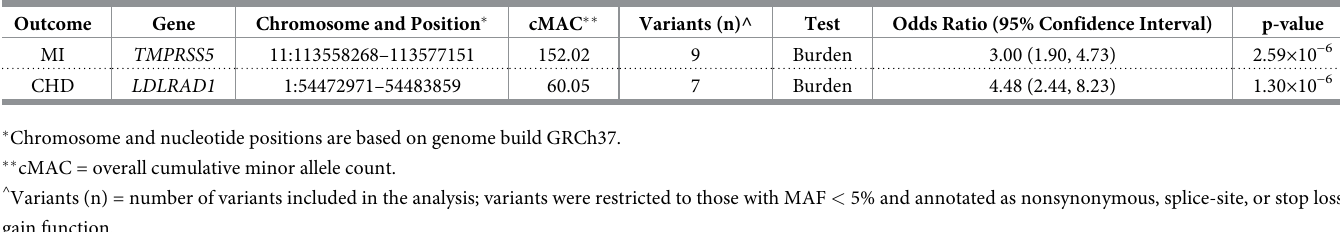
Table 2. Genes associated with prevalent MI and CHD in gene-based analysis.